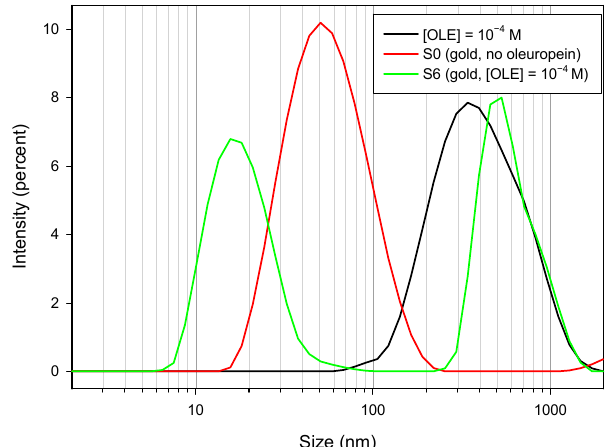
Figure 8. Intensity/size distribution pattern for a solution of [OLE] = 10 − 4 M (black line); oleuropein-free borohydride nanoparticles, sample S0 (red line); and sample S6, containing [OLE] = 1 × 10 − 4 (green line) .